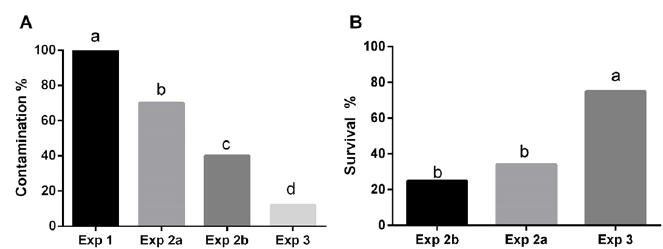
Figure 4. Establishment of pitaya sterile coltures. ( A ) Contamination percentage of different sterilization protocols after 15 days of culture: Experiment 1 (Exp 1), Experiment 2a (Exp